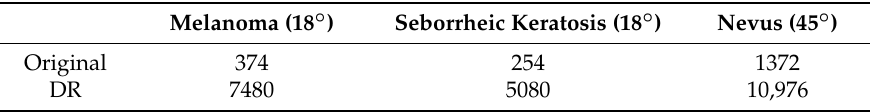
Table 1. Detailed information of data augmentation (task 1 & 3).